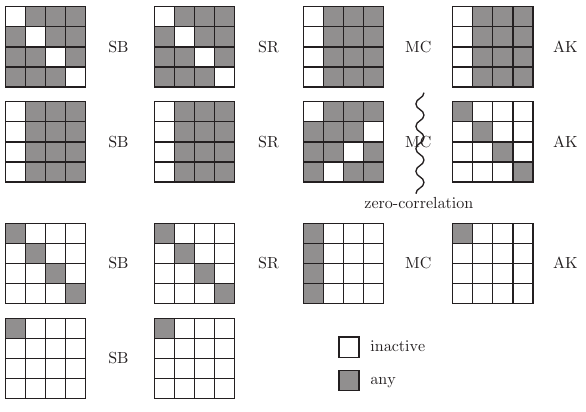
Figure 7: Zero-correlation linear hull on 4-round AES